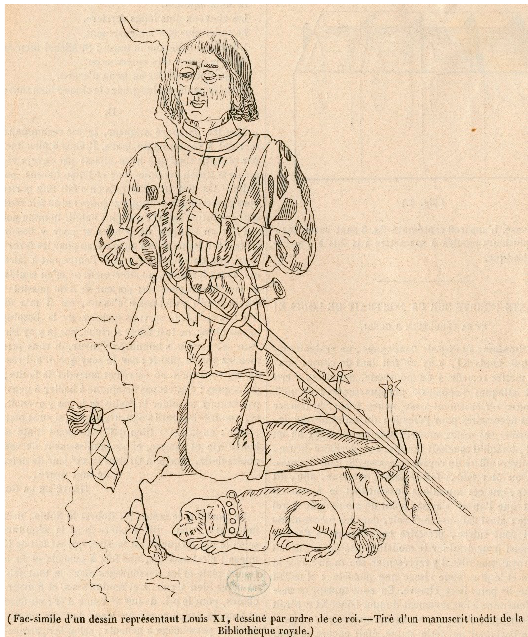
Figure 6. Kneeling portrait of Louis XI , modern facsimile of a sketch by an unknown artist, Paris, Bibliothèque nationale de France, Ms. Fr. 20493, fol. 5r. Source: bibliothèque interuniversitaire de santé, Wikimedia Commons, Open Licence.